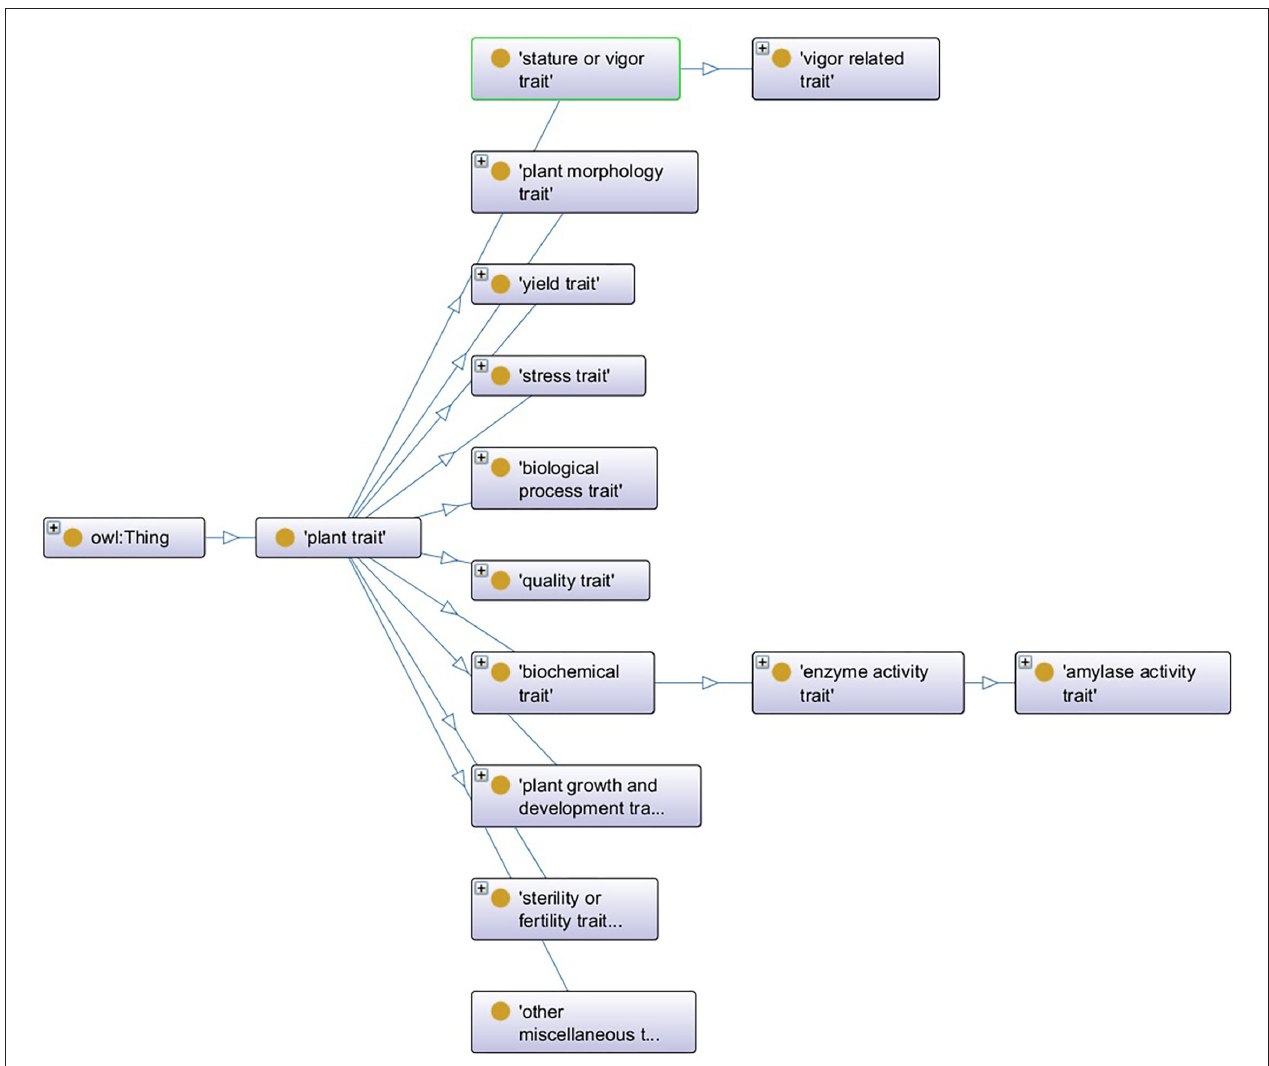
FIGURE 1 | A segment of plant trait